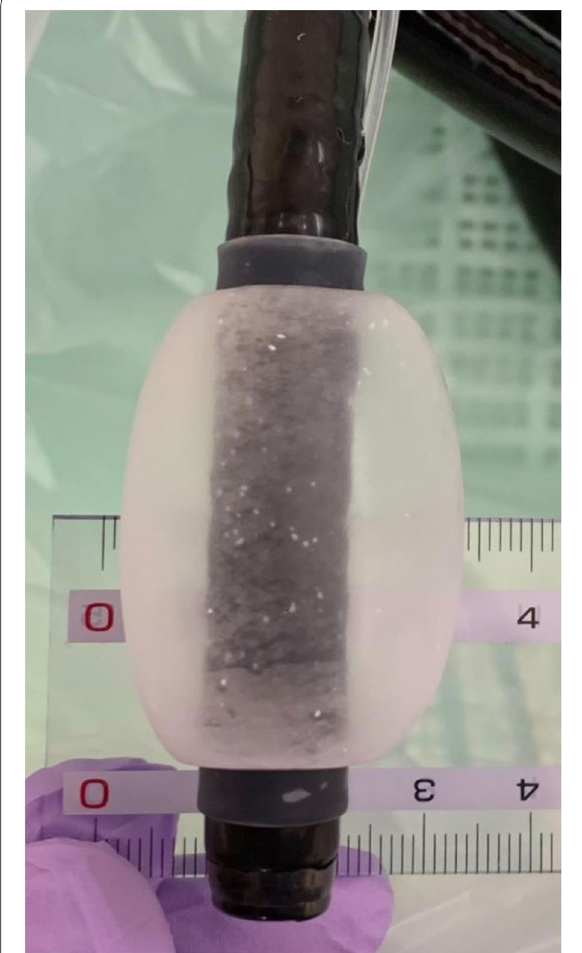
Fig. 3 Postoperative verification of the balloon size. The maximum diameter of the balloon was 32 mm when 20 ml of air was injected into the esophageal varices